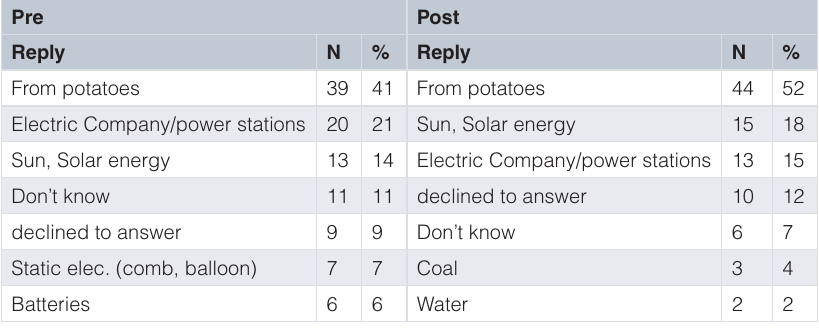
Table 2. Comparison of knowledge before and after the learning session. “Which ways do we get or create electricity” top 7 replies. Pre